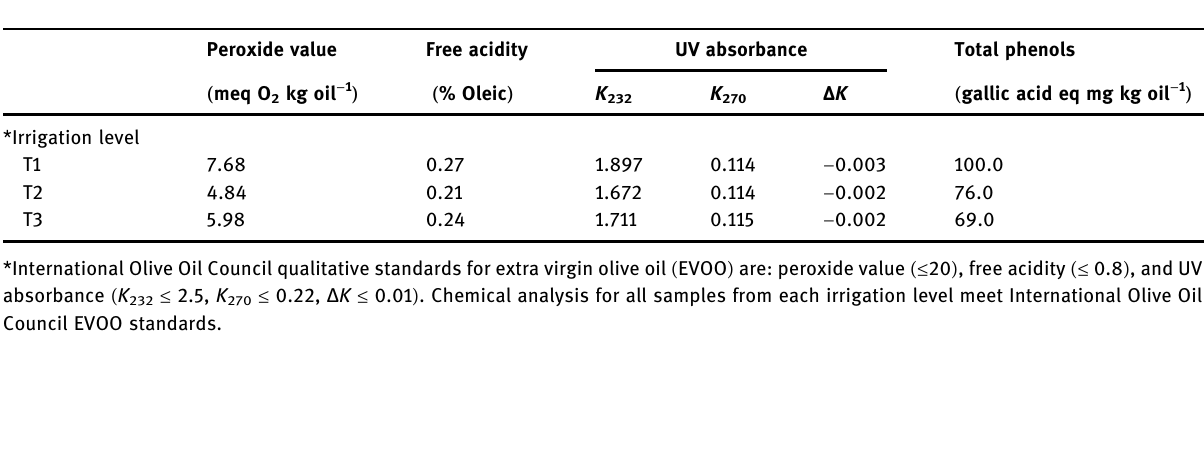
Table 2: E ff ect of irrigation regime ( T1 – one emitter tree − 1 , T2 – two emitters tree − 1 , T3 – three emitters tree − 1 ) on olive ( Olea